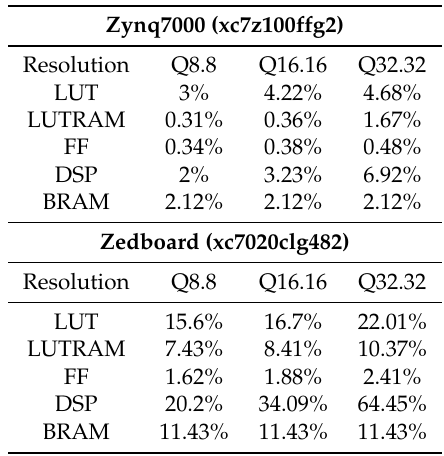
Table 3. Programmable logic resources as a function of numerical precision.